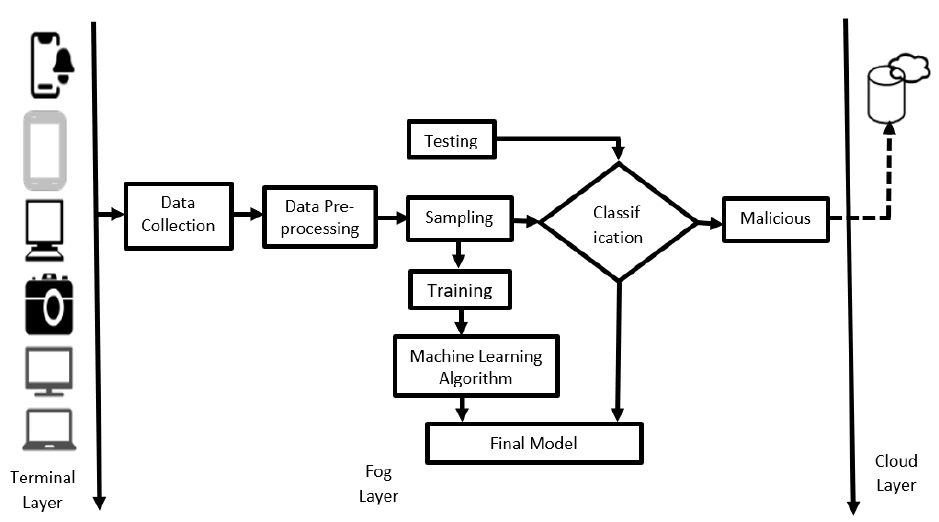
Figure 2. Proposal model for IoT machine learning-based